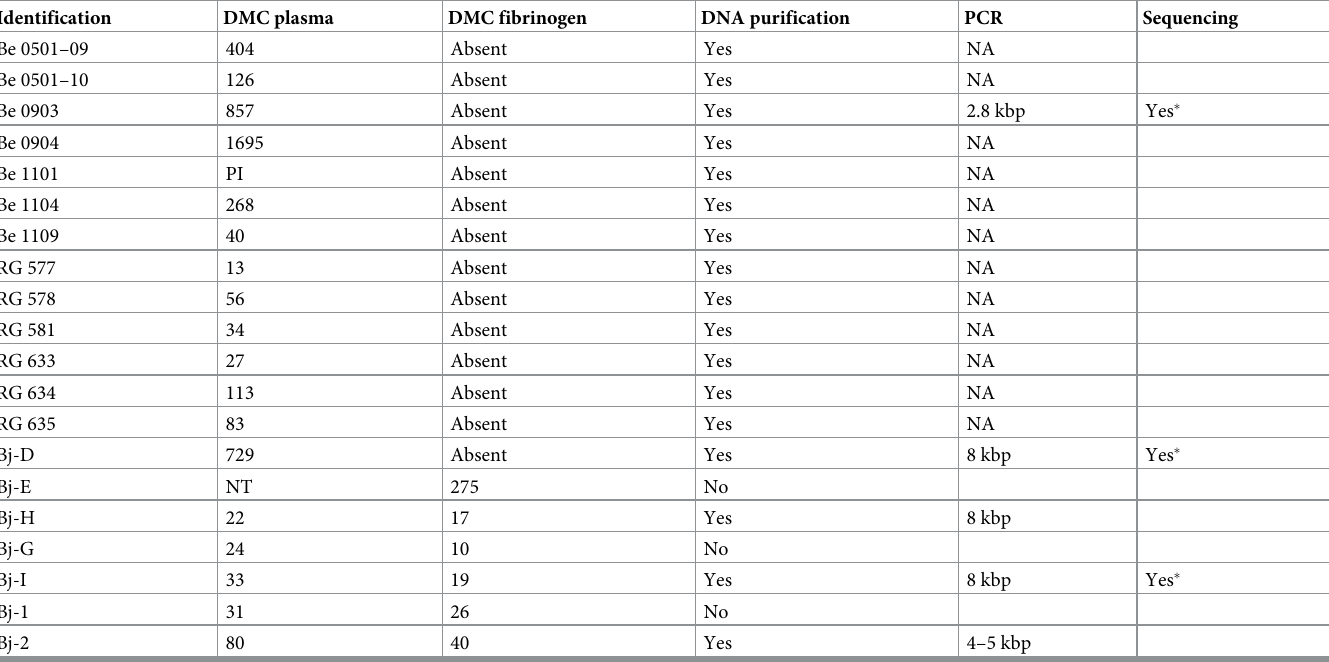
Table 1. Coagulant activities of B . jararaca and B . erythromelas snake venoms on bovine plasma and fibrinogen, and DNA sequencing analyses.